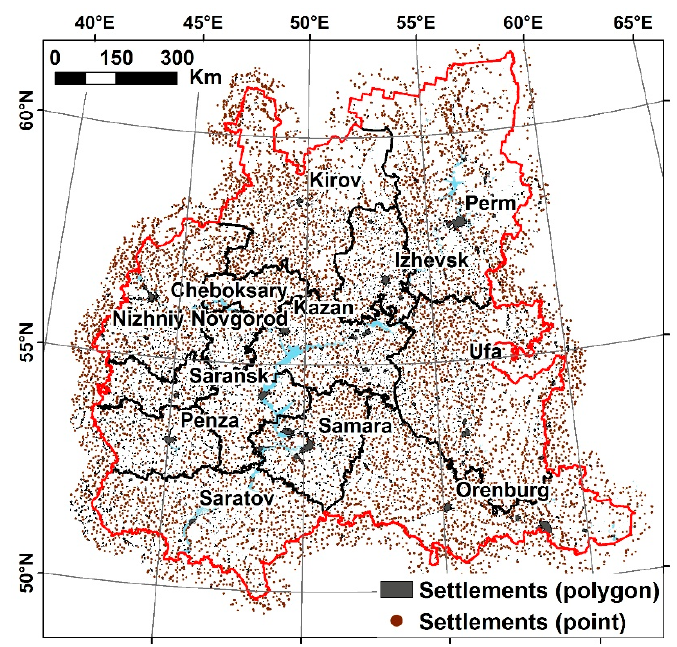
Figure 3. Vector layers of settlements used to calculate population density.